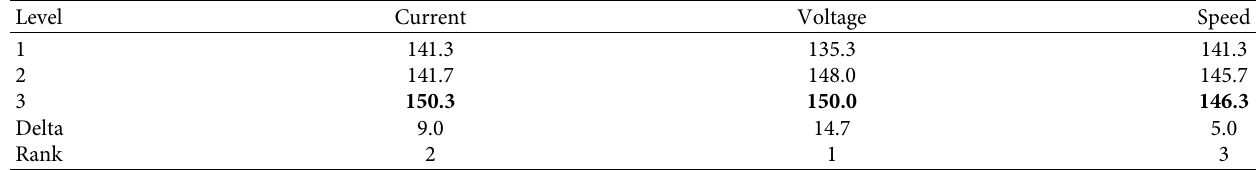
Table 11: Response table for S/N ratio of the hardness of HAZ.